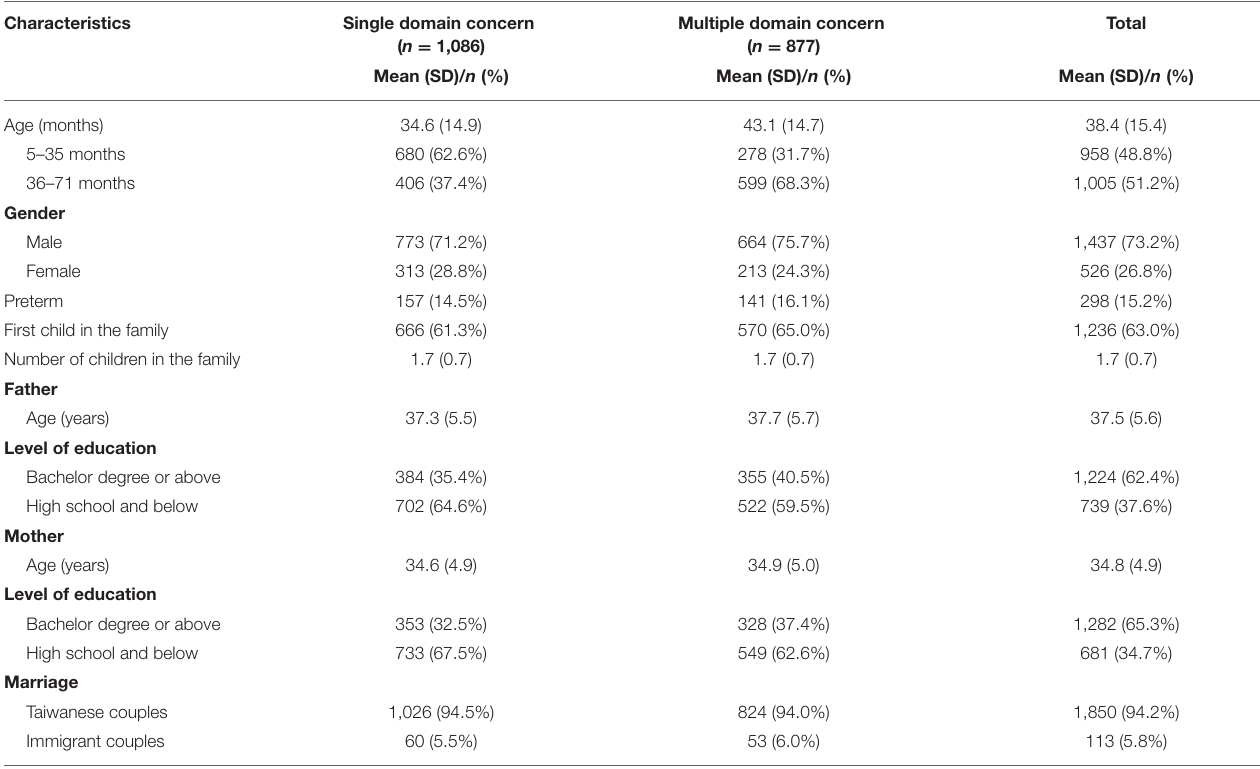
TABLE 1 | Sample and family characteristics ( N = 1,963).